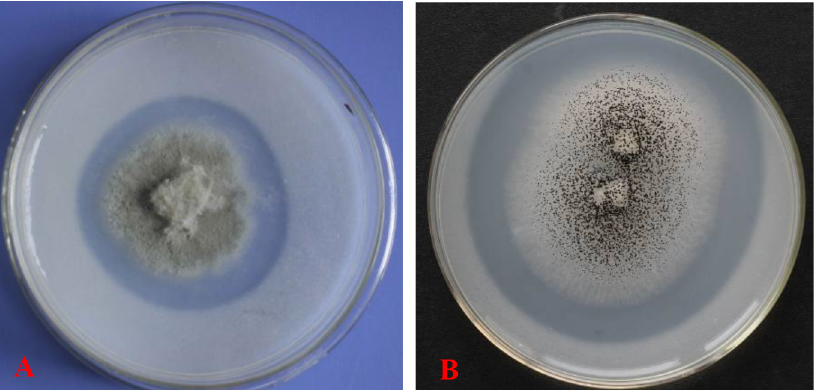
Fig 1. Zones of phosphate solubilization on Pikovskaya’ s agar plates produced by TalA-JX04 (A) and AspN-JX16 (B) incubated at 25˚C.